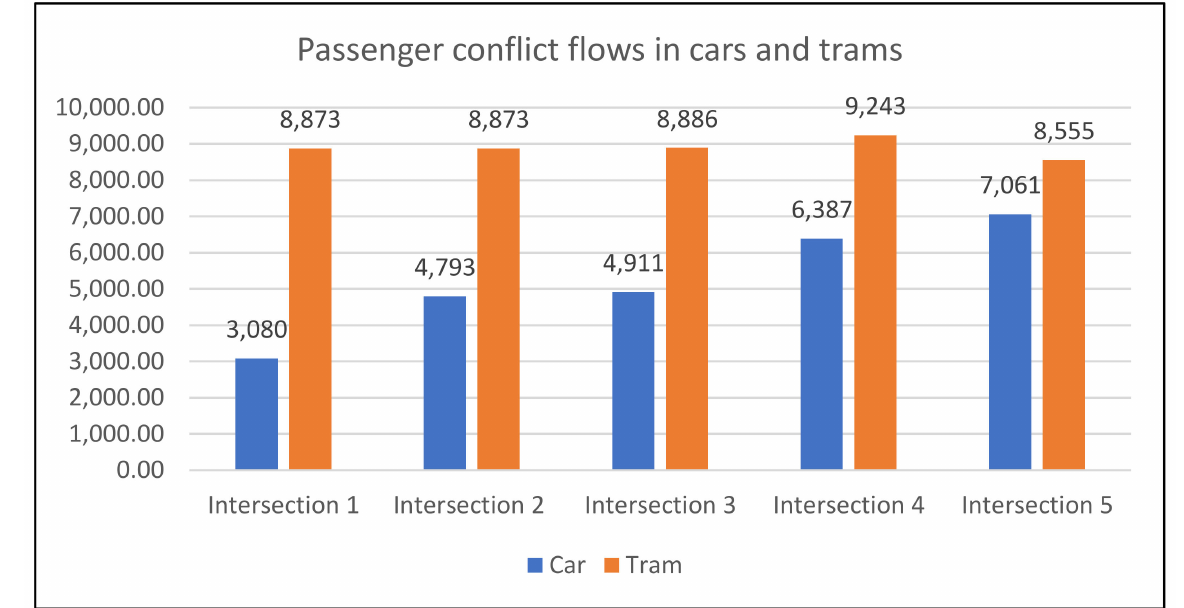
Figure 5. Passenger conflict flows in cars and trams on five most saturated intersections.